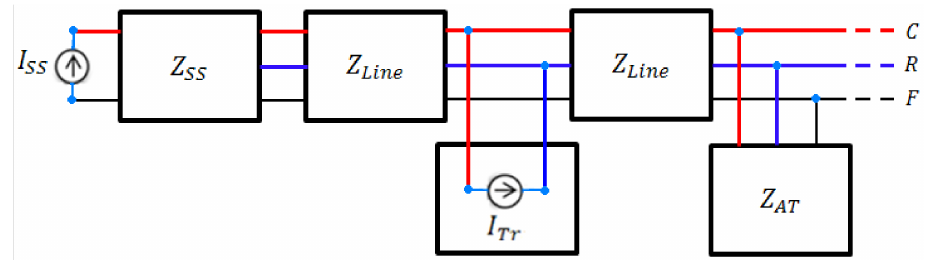
Figure 4. Block diagram model of the electric railway